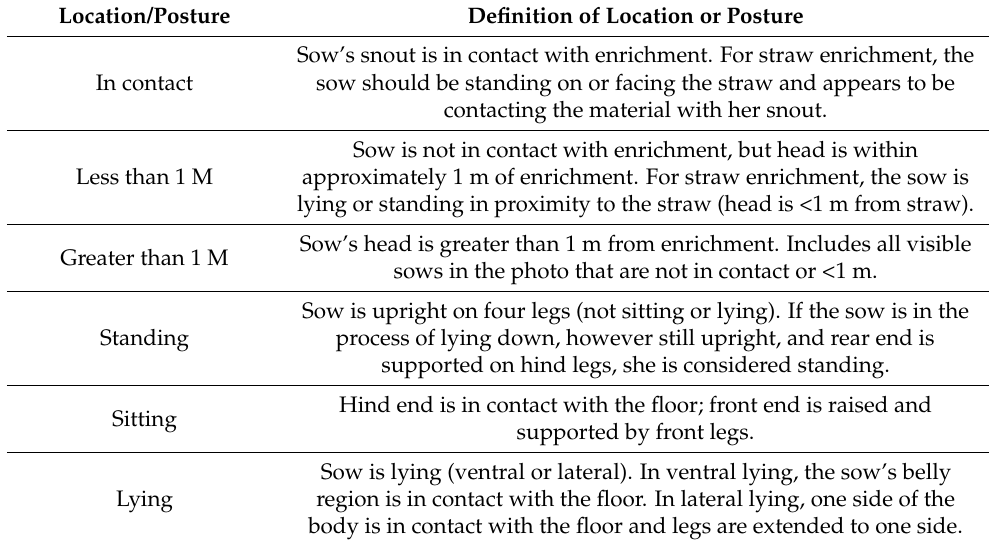
Table 1. Ethogram used to identify sow posture and location relative to enrichment. Adopted from Roy et al. [10]. Location/Posture